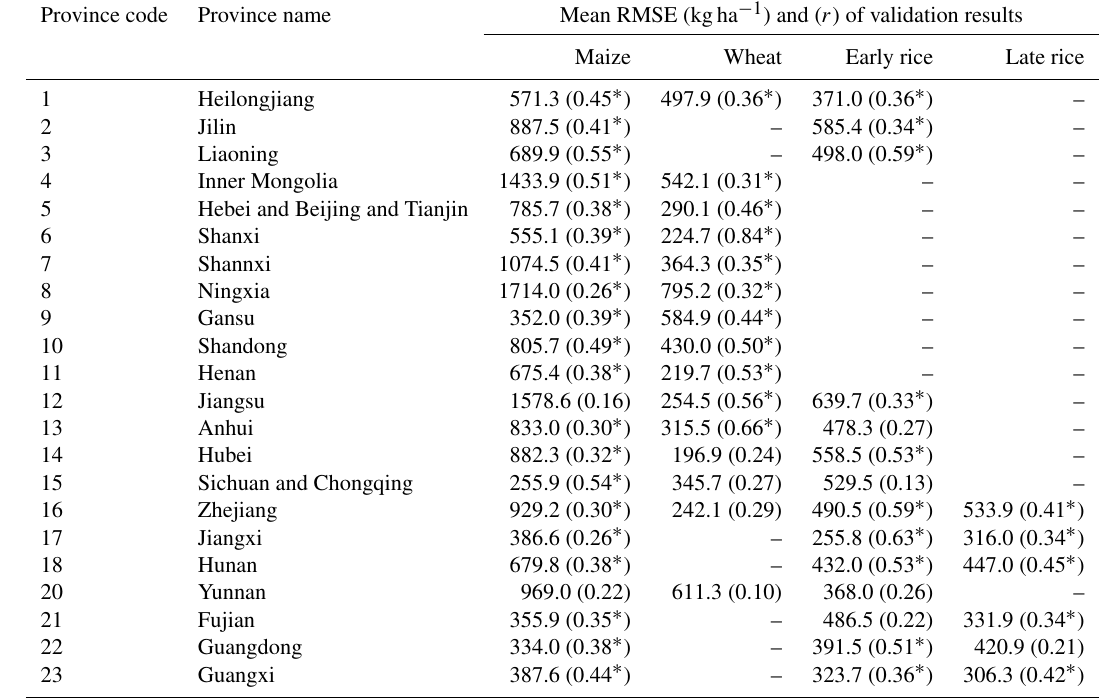
Table 1. Validation of the MCWLA family models for maize, wheat and rice in different provinces of China. Province